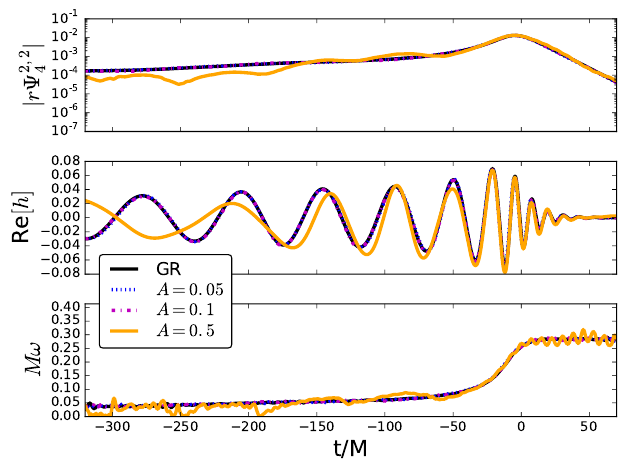
Figure 2 . Results for the inspiral and coalescence of two, equal-mass black holes, for varying amplitudes A of the quantum (cid:13)uctuations. These runs have M (cid:10) = 0 : 1 and R 0 = 0 : 3 M . The times and overall phases of the nonviolent nonlocality waveforms have been shifted to maximize the overlap with the GR waveform. Top: the magnitude of the gravitational wave scalar j r (cid:9) 2 ; 2 Middle: the real component of the strain h . Bottom: the angular frequency ! of the binary.